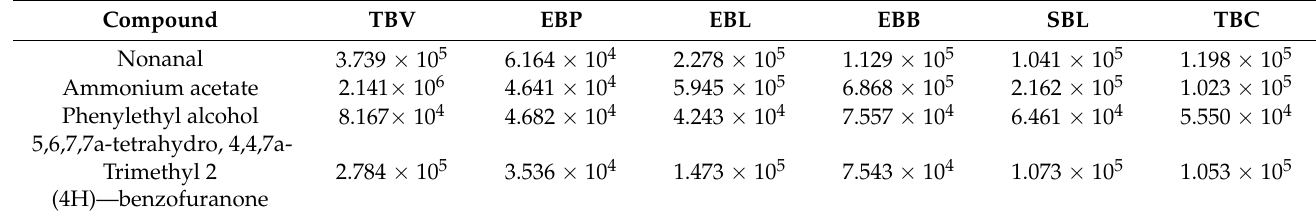
Table 4. Common compounds between the analyzed black